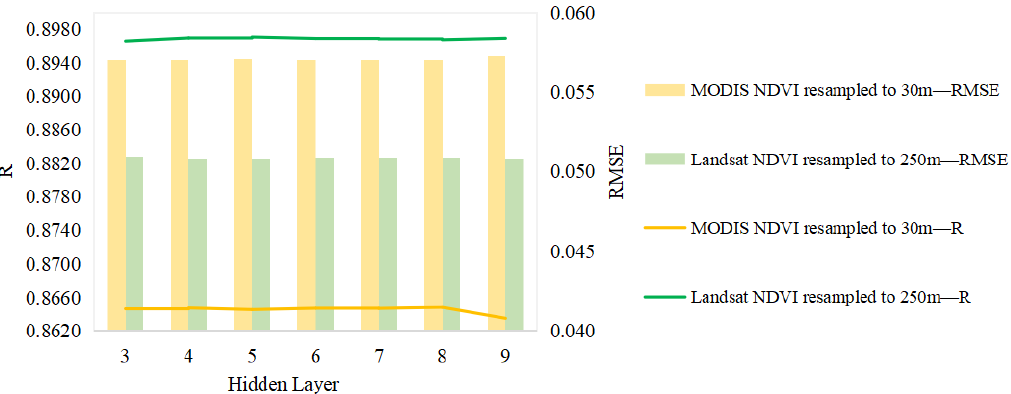
Figure 12. RMSE and R for two resampling methods (Landsat resampled to 250 m; MODIS resampled to 30